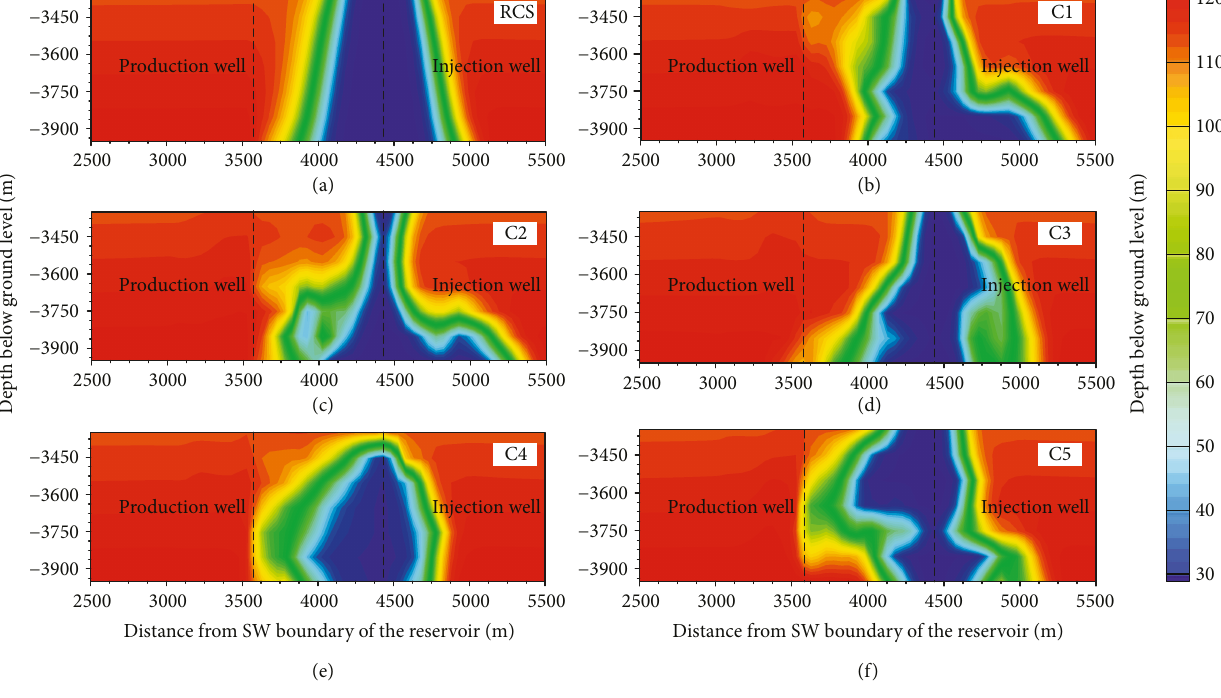
Figure 9: The temperature distribution along a 2D SW-NE trending cross section of the reservoir after 50 years in the reference case simulation ((a) RCS) and fi ve cases in the heterogeneity of permeability ((b) C1, (c) C2, (d) C3, (e) C4, and (f) C5). Black dotted lines represents the location of injection well and production